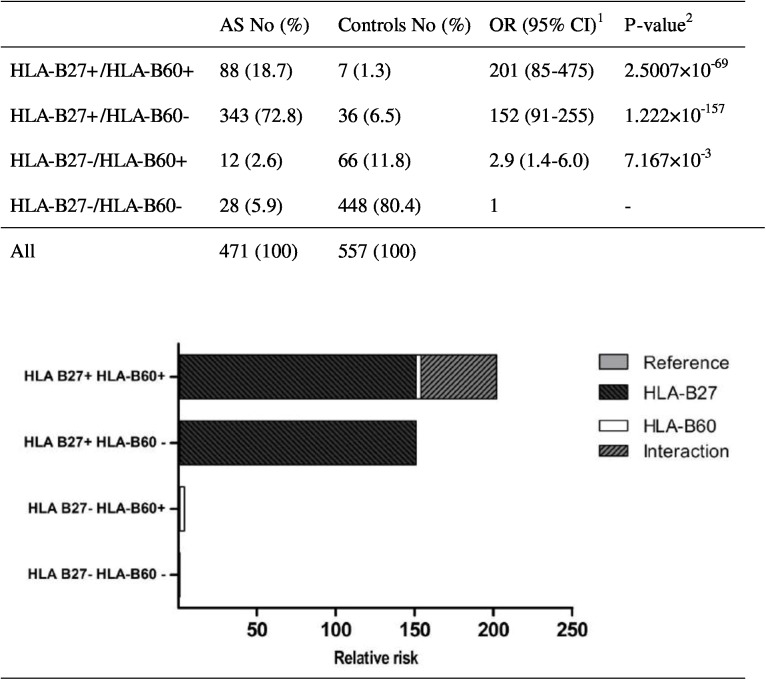
Interaction between HLA-B60 and HLA-B27 in ankylosing spondylitis susceptibility in a Taiwanese population with contribution of the different genes to the odds ratio (OR) marked.
1Odds ratio is calculated by unconditional maximum likelihood estimation and 95% confidence intervals are calculated using normal approximation (Wald method). 2
P-value is calculated by Fisher-exact test. AS: ankylosing spondylitis; CI: confidence interval; No: number of individuals; OR: odds ratio.